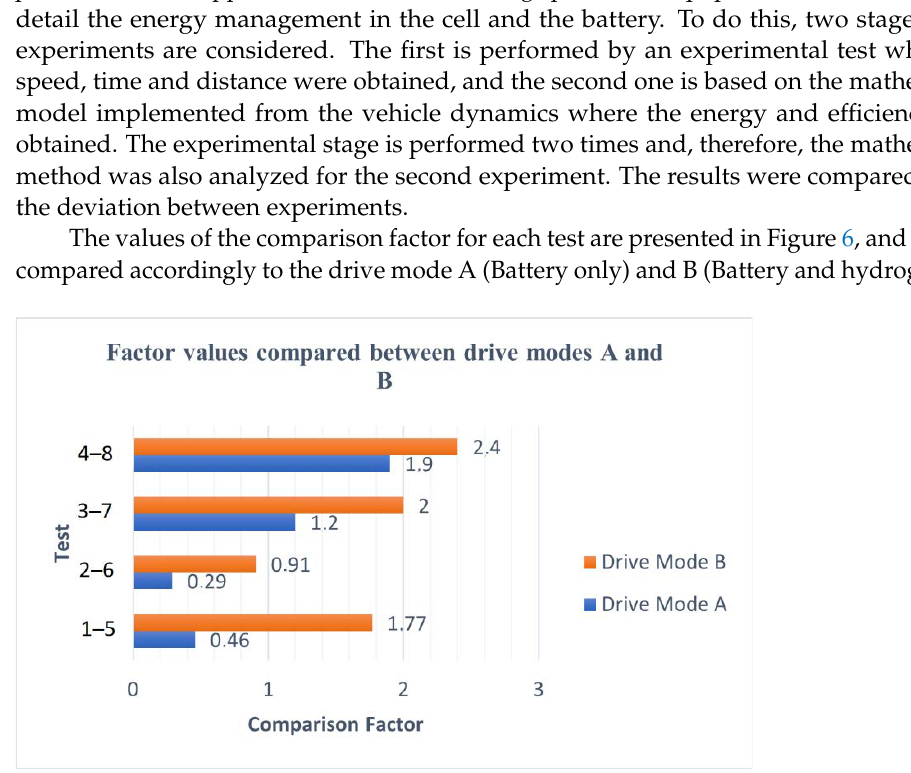
Figure 6. Graph with the values for the comparison factor accordingly to the drive mode A and B. By: